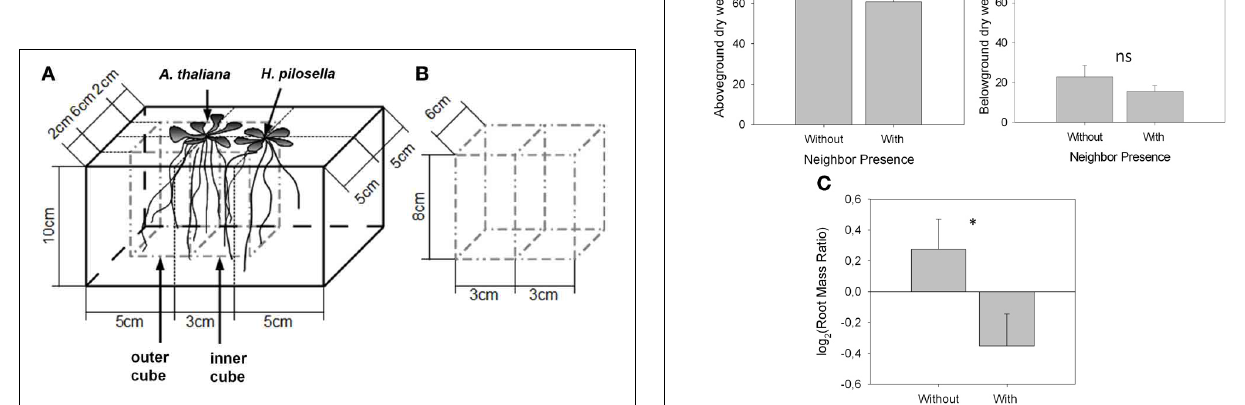
FIGURE 1 | Sketch of the method to assess Arabidopsis thaliana root reactions to the presence/absence of neighbors. (A) , Plant container indicating the arrangement of plants and dimensions of the inner and the outer cubes cut at harvest. The position of the “neighbor”can either be filled by a plant of Hieracium pilosella or remain unfilled (control). Note that the central cut line is situated directly under the A. thaliana stem. (B) , Dimensions of the two-chambered open-bottomsteel frame used to cut the cubes.